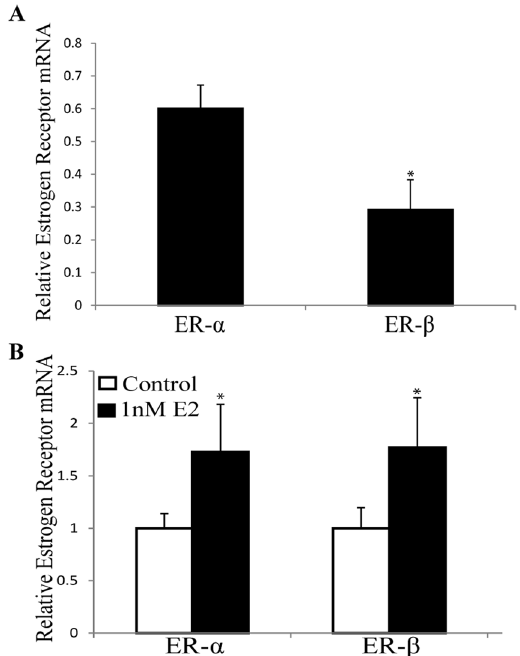
Figure 5. Transcripts encoding estrogen receptor (ER)- α and ER- β are estrogen-responsive in 3T3-L1 cells. Transcript abundance was determined by qRT-PCR and normalized to 18 S controls. ( A ) ER- α transcript abundance is greater than ER- β . * Denotes p-value ≤ 0.05 where levels of the receptor transcripts are compared. ( B ) When treated with 1 nM estradiol, the abundance of transcript of both receptors were increased. The values are normalized to untreated controls for each transcript to illustrate that both receptors have similar induction by estradiol. Mean ± S.E.M; n ≥ 3; * Denotes p-value ≤ 0.05 when compared to control with 2-sample, independent Student’s